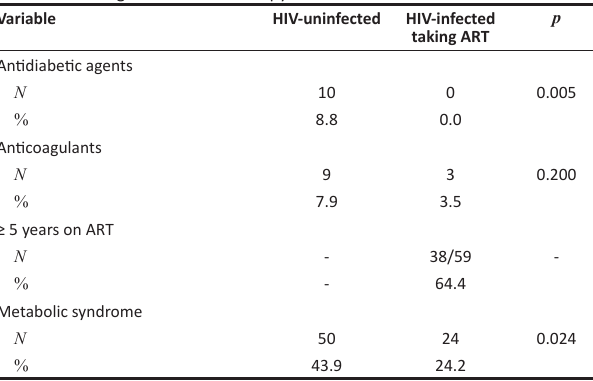
Data are arithmetic mean ± s.d. or geometric mean (5th and 95th percentile intervals) for logarithmically transformed variables.